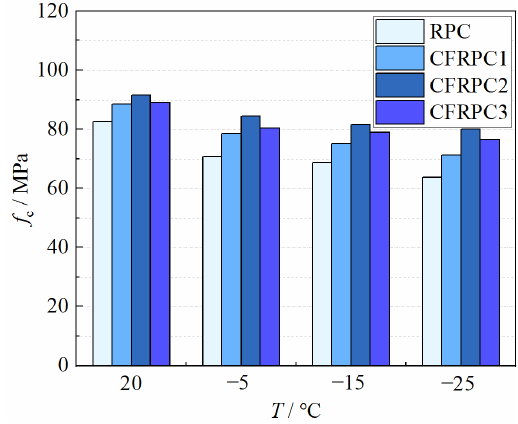
Figure 10. Relationship f c vs. T .